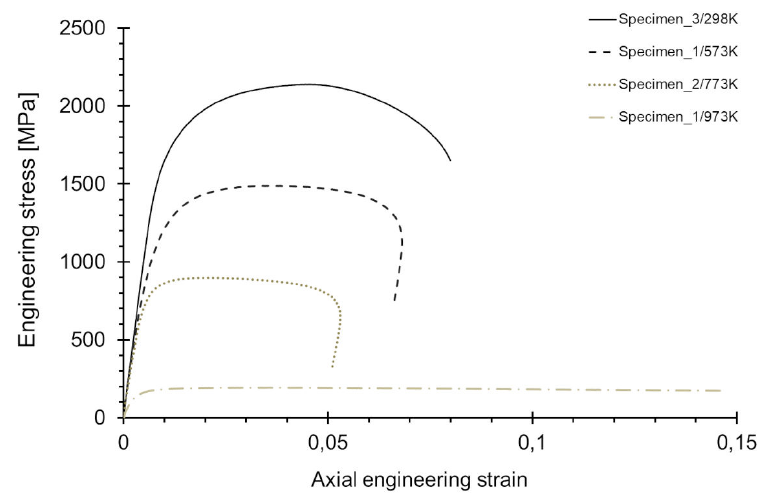
Figure 8. Comparison of the σ-ε tensile curves for the temperature levels tested. Logarithmic axial strain (so-called true strain) maps in the area of the neck were ob- tained as the DIC measurements were taken. Logarithmic strains are more relevant in the case of high strains that occur in the necking area of the specimen than engineering strains.